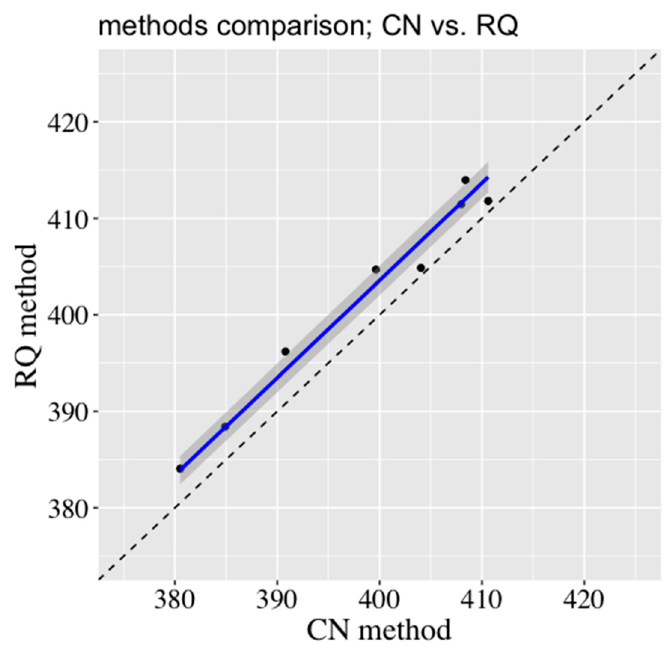
Figure 3. Regression analysis of HP determined by the RQ method in relation to HP measured from the CN method (solid line). Y = X is represented by a dashed line.